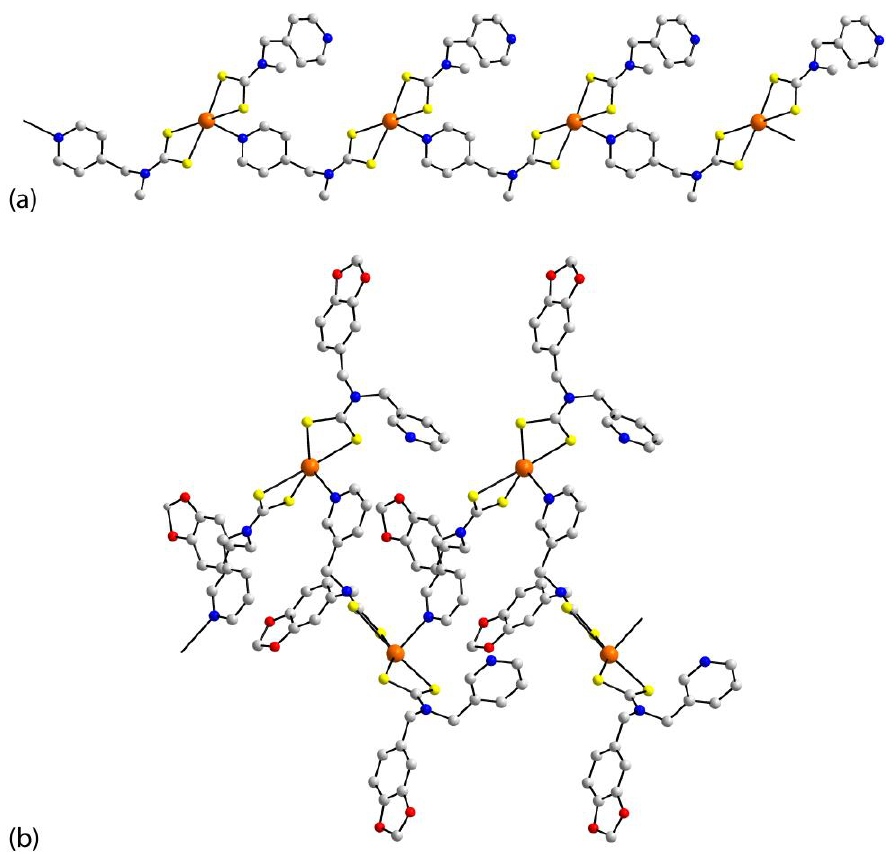
Figure 15. The supramolecular chain mediated by the Hg · · · S interactions in ( a ) linear [Hg(L 21 ) 2 ] n ( 49 ) and ( b ) zig-zag [Hg(L 23 ) 2 ] n ( 50 ). One of the homoleptic mercury dithiocarbamates assembled into a two-dimensional array in the crystal, i.e., [Hg(L 9 ) 2 ] n ( 51 ) [35]. Different views of the assembly are shown in Figure 16. The mercury atom lay on a center of inversion and was coordinated by the